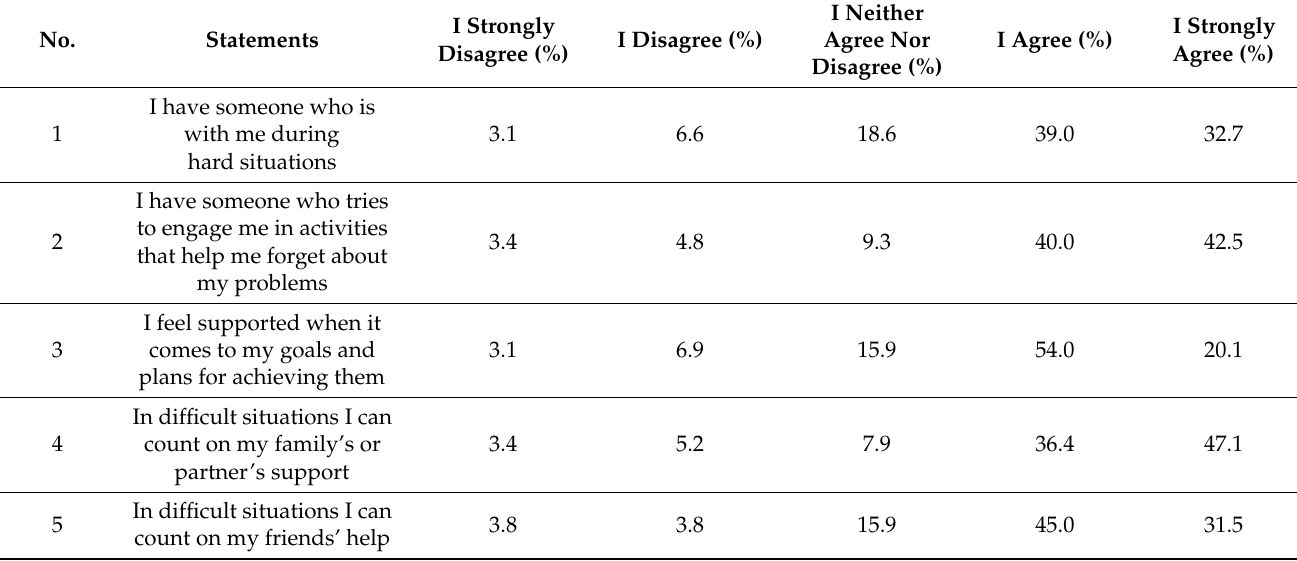
Table 2. Behaviour mainly related to psychosocial health: using and providing social support, avoiding excessive stress and dealing with problems and tensions.